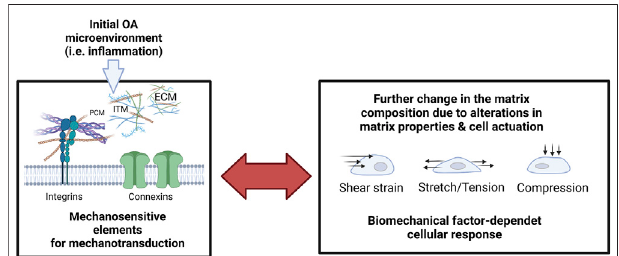
FIGURE 10 | The reciprocity of cellular mechanosensation escalates the pathological response during in fl ammatory onset and progression of OA. Microenvironmental factors of the extracellular matrix (extracellular matrix, ECM; pericellular matrix, PCM; Interterritorial matrix, and ITM) are monitored by cell-bound mechanosensitive structures such as integrins and connexins that again mediate dysfunctional cell activity and pathological matrix biosynthesis. Pathological mechanosignaling in turn in fl uences the cellular sensation towards shear strain, stretching, and compressive loading. Created with permissions from Biorender.com.